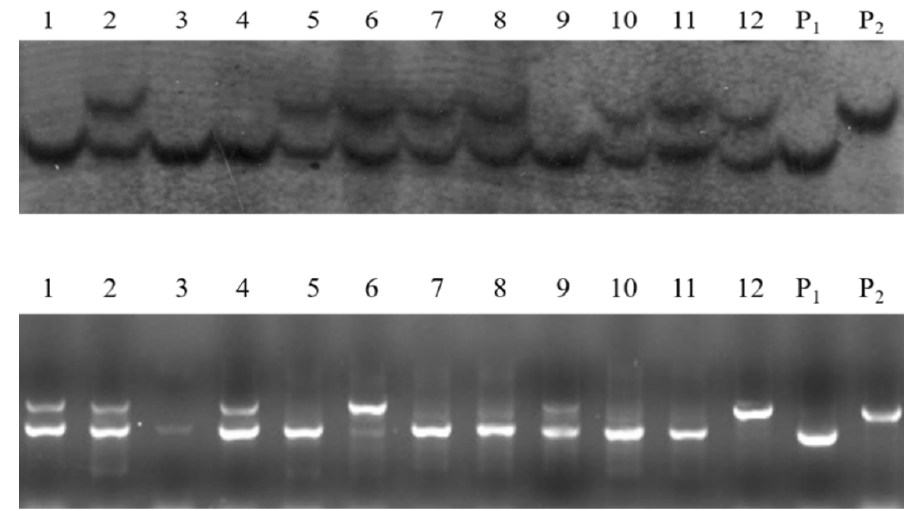
Figure 3. Genotype of partial individuals of F 2 population for locular number (up) and self-compat- ibility (down). P 1 : CR BJN3-2; P 2 : KYS; 1-12: F 2 individual plant number.